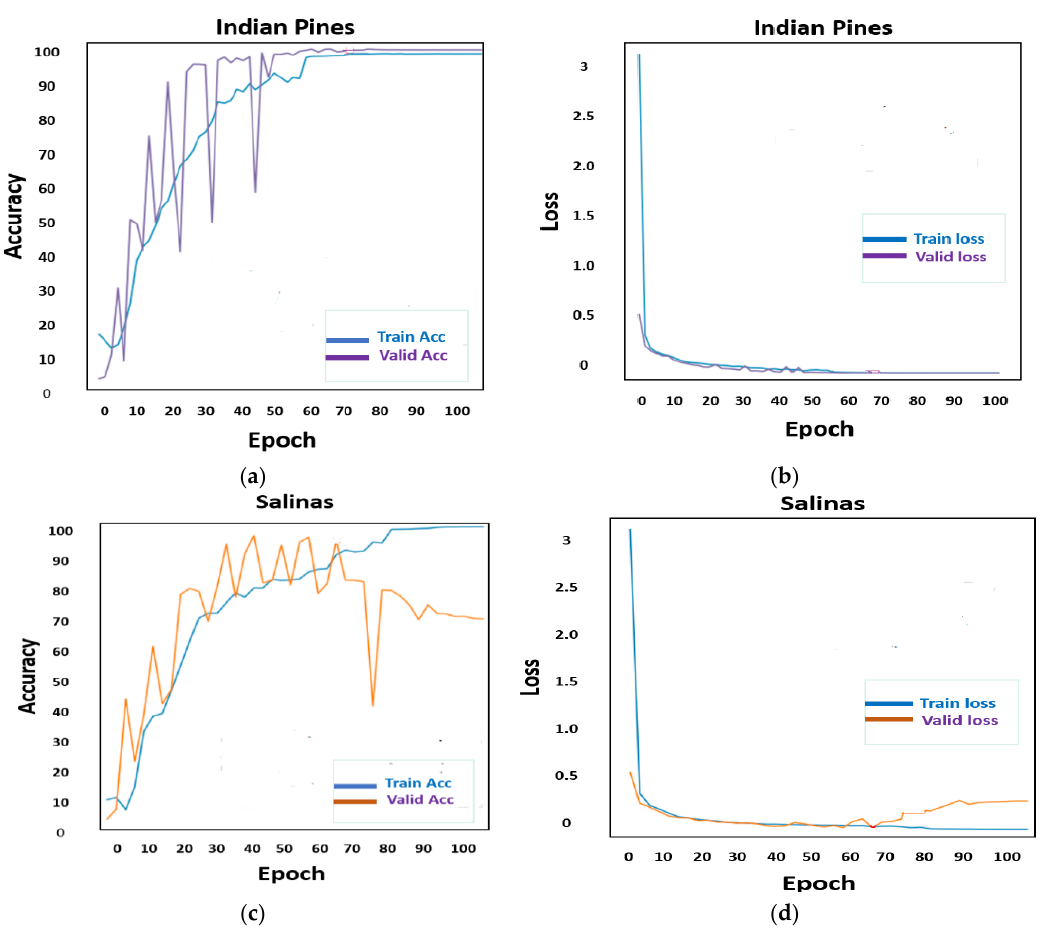
Figure 10. Learning curves for Indian Pines (IP) and Salinas (SA) datasets with cutout regulariza- tion: ( a ) accuracy of IP; ( b ) loss of IP; ( c ) accuracy of SA; and ( d ) loss of SA.